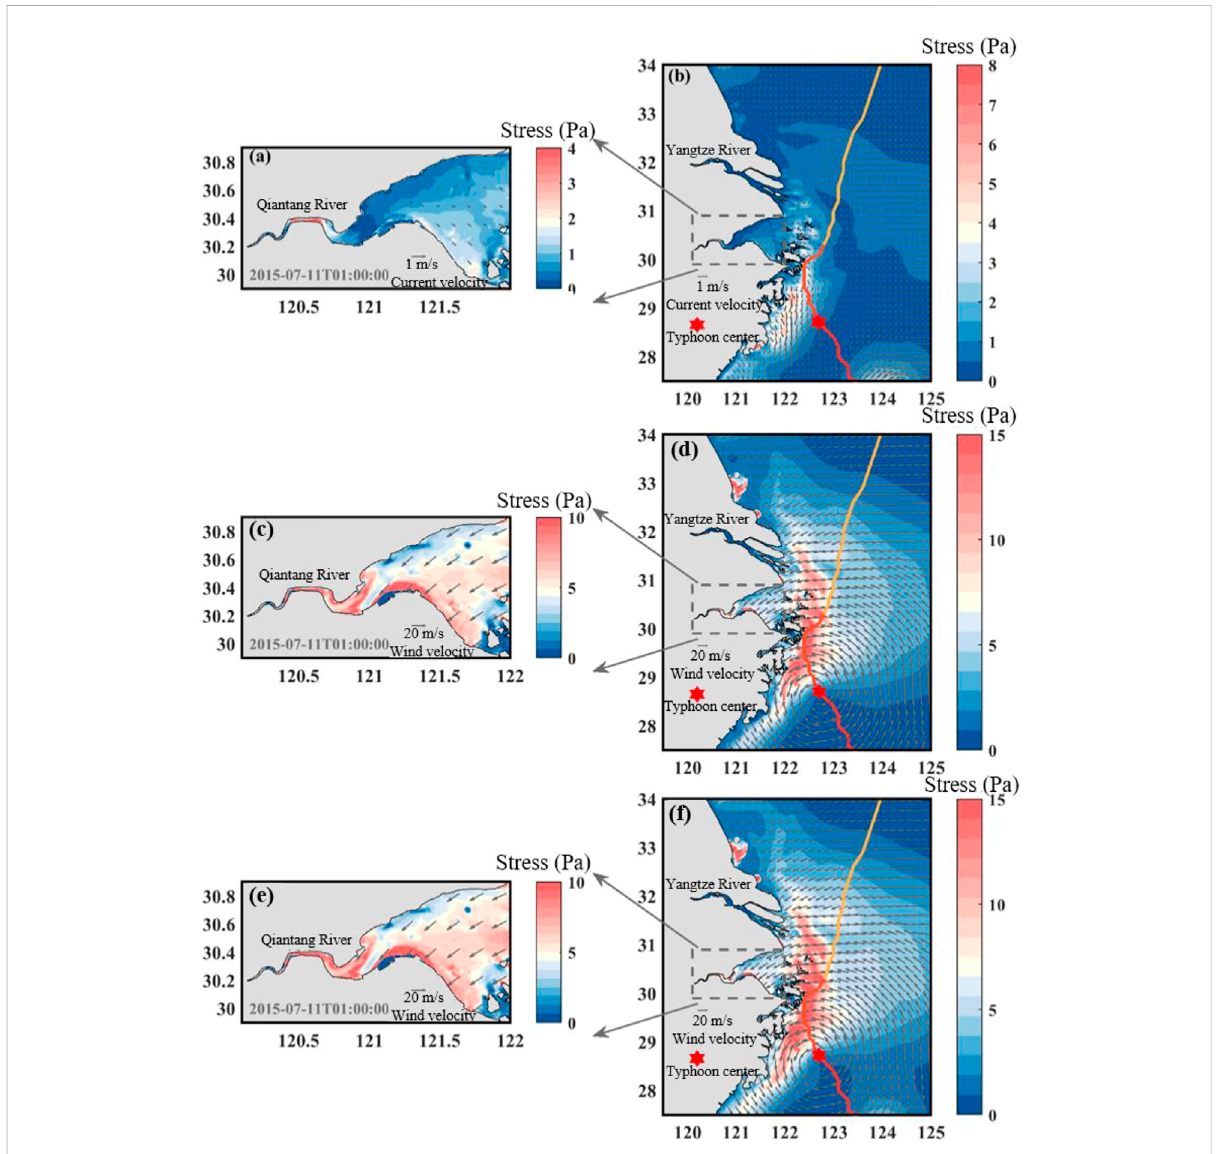
FIGURE 11 Bottom stress induced by (A,B) currents (arrow indicates bottom current velocity), (C,D) waves (arrow indicates wind velocity), and (E,F) combined action of currents and waves (arrow indicates wind velocity) at 01:00 on 11 July 2015 (the red and orange gradient line indicates typhoon path, the red six-pointed star indicates typhoon